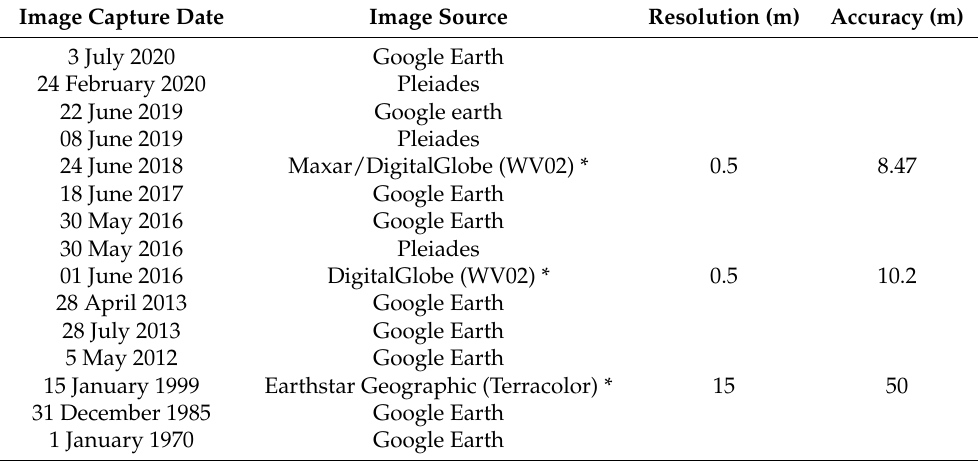
Table 2. Satellite imagery analyzed in this